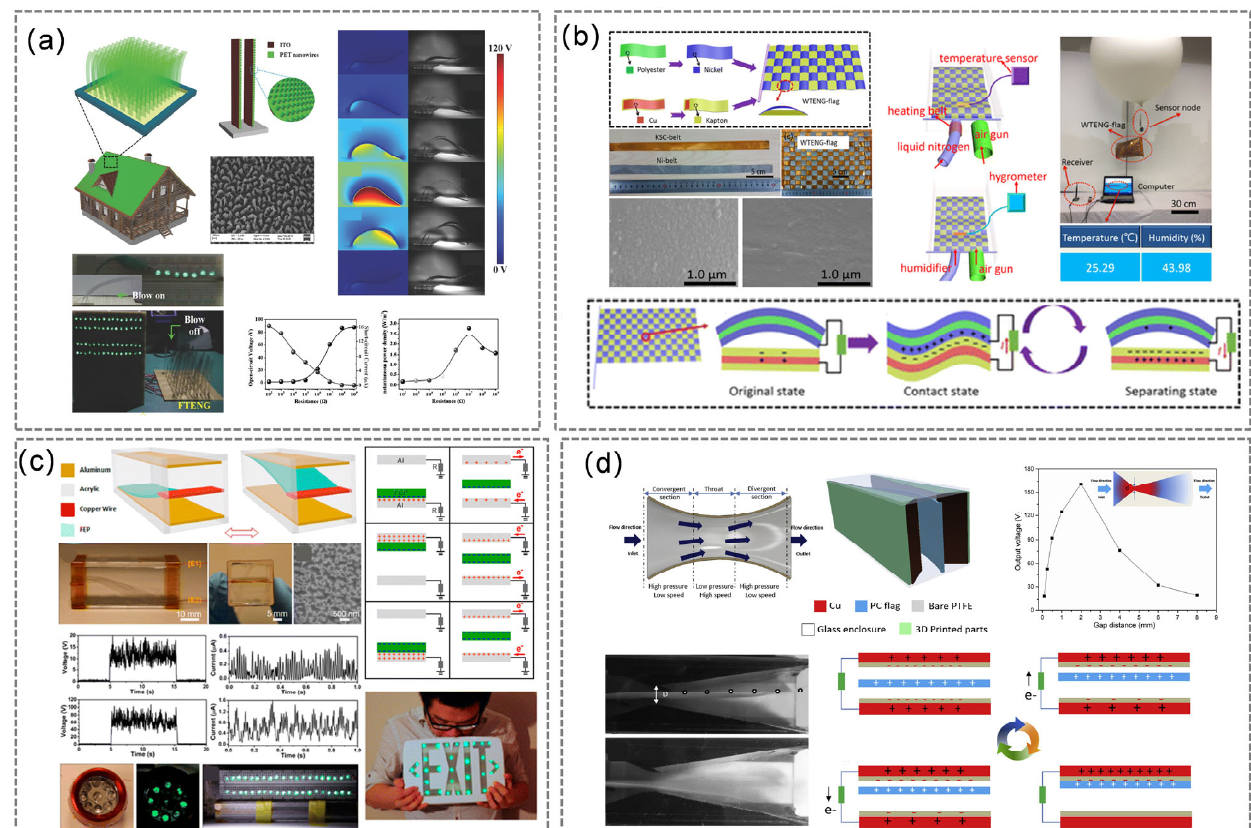
Figure 5. Flutter-based mechanism: ( a ) lawn-structured TENG on a rooftop (reproduced with permission [49]. Copyright 2016, Advanced Materials ). ( b ) Schematic and working mechanism of woven triboelectric nanogenerator flag (WTENG-flag) (reproduced with permission [50]. Copyright 2016, ACS Nano ). ( c ) Schematic of the triboelectric nanogenerator (reproduced with permission [51]. Copyright 2013, ACS Nano ). ( d ) TENG based on wind-actuated venturi design system (reproduced with permission [52]. Copyright 2019, Nano Energy ).